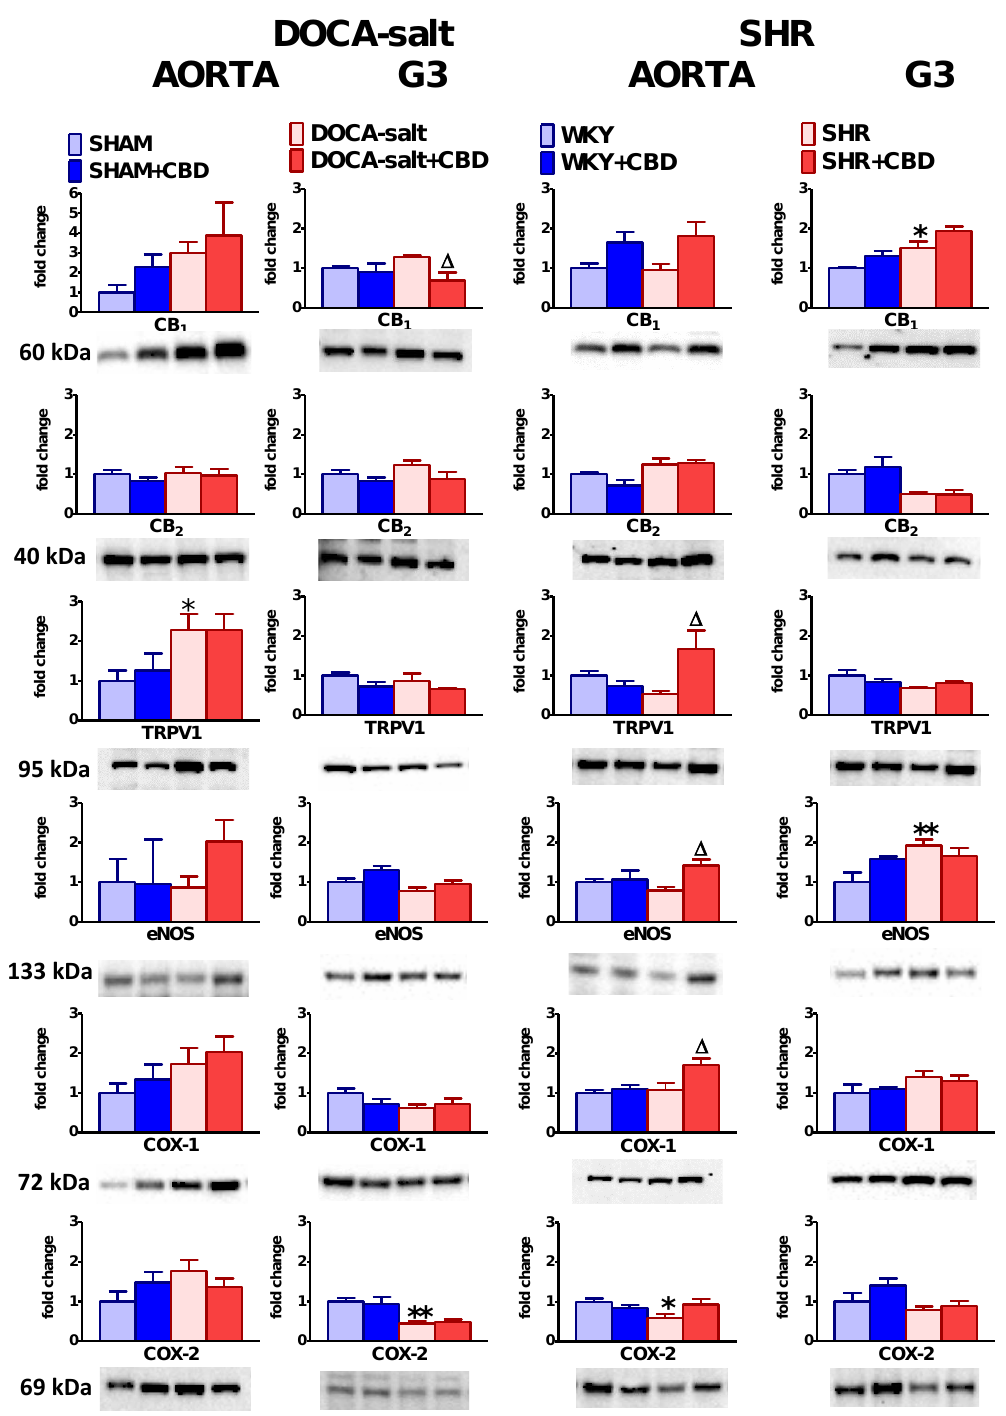
Figure 7. Influence of cannabidiol (CBD) and its vehicle on the expression of CB 1 , CB 2 , TRPV1 receptor, endothelial nitric oxide synthase (eNOS), cyclooxygenases 1 and 2 (COX-1, COX-2) in thoracic aortas and mesenteric G3 arteries isolated from deoxycorticosterone-induced (DOCA-salt) and spontaneously (SHR) hypertensive rats and their normotensive controls, sham-operated (SHAM) and Wistar–Kyoto (WKY) rats, respectively. CBD (10 mg/kg) or its vehicle was injected i.p. every 24 h for 14 days. Vessels were prepared 24 h after the final injection. Receptor protein was determined by Western blots and is given as fraction of the value in the normotensive control (first of the four columns). Images obtained using stain-free gel technology that allows for total protein visualization and quantification are shown with a loading control (Loading). Mean ± SEM, n = 5–6 tissues for each bar. * , ∆ p < 0.05 and ** p < 0.01 compared to the respective control groups (* SHAM/WKY or ∆ DOCA-salt/SHR), as determined by one-way ANOVA followed by Bonferroni’s multiple-comparison